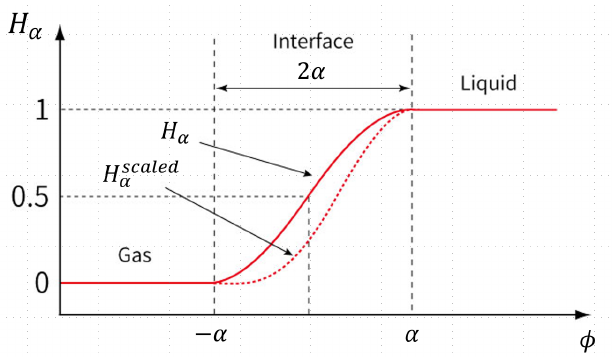
Figure 4. Smoothed Heaviside function and density-scaled Heaviside